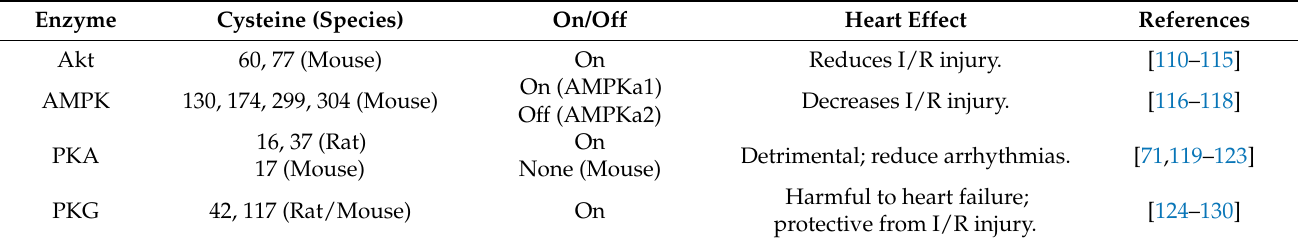
Table 1. Cysteine Oxidation of Cardioprotective